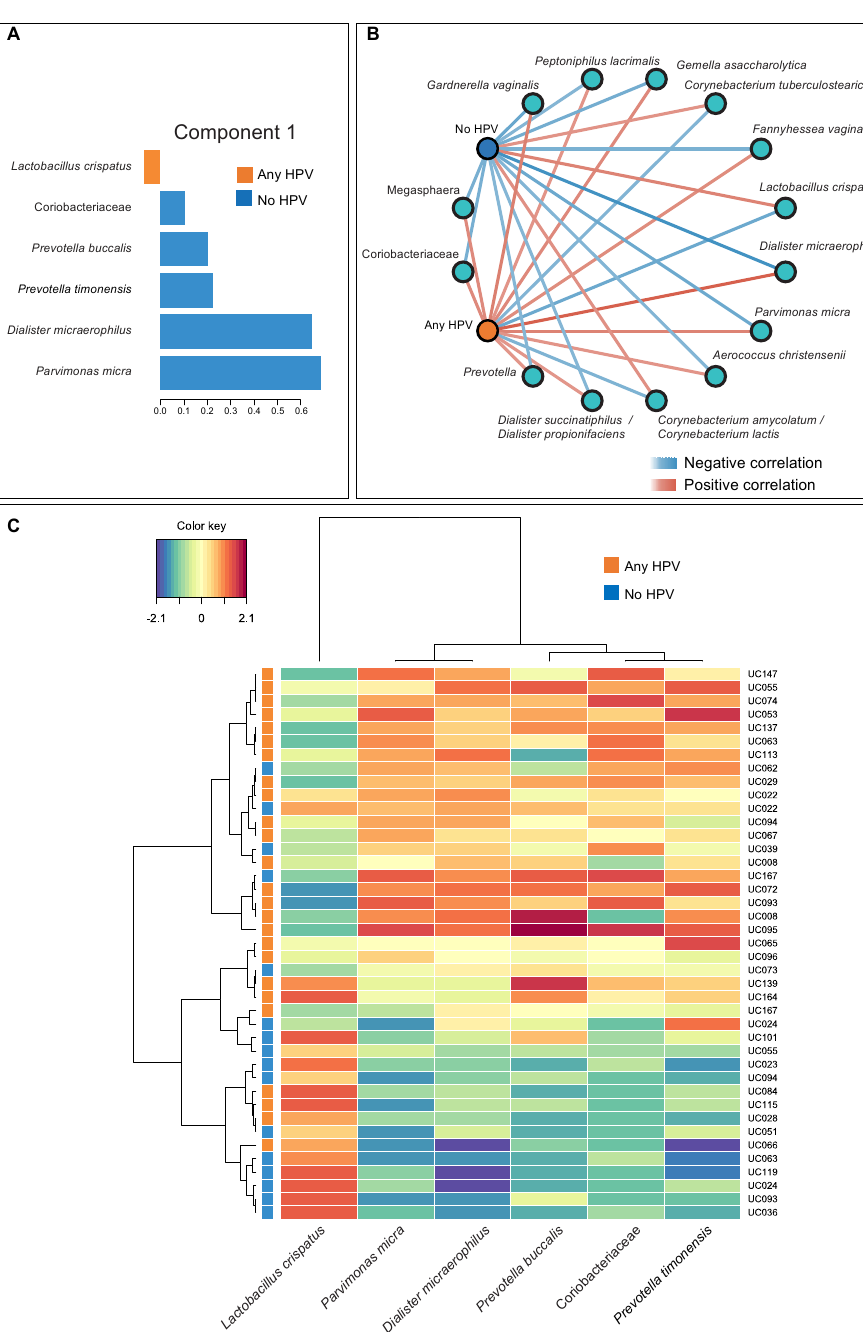
Figure 4. Distinguishing women with HPV versus without HPV based on vaginal microbiota composition. ( A ) Loadings plot showing the contribution of the different bacterial taxa selected by sparse PLS-DA (sPLSDA) that explain the highest variance in the comparison of samples from women with any HPV (orange) and from women without any HPV (blue). ( B ) A network analysis of the bacterial taxa selected by sPLSDA. Positive correlations are shown in red, while negative correlations are shown in blue. ( C ) Unsupervised clustering of the selected bacterial taxa, annotated by HPV status with orange indicating the presence of any HPV and blue indicating the absence of HPV in a sample. This analysis includes samples from the 33 women included in the viral metagenome sequencing project.